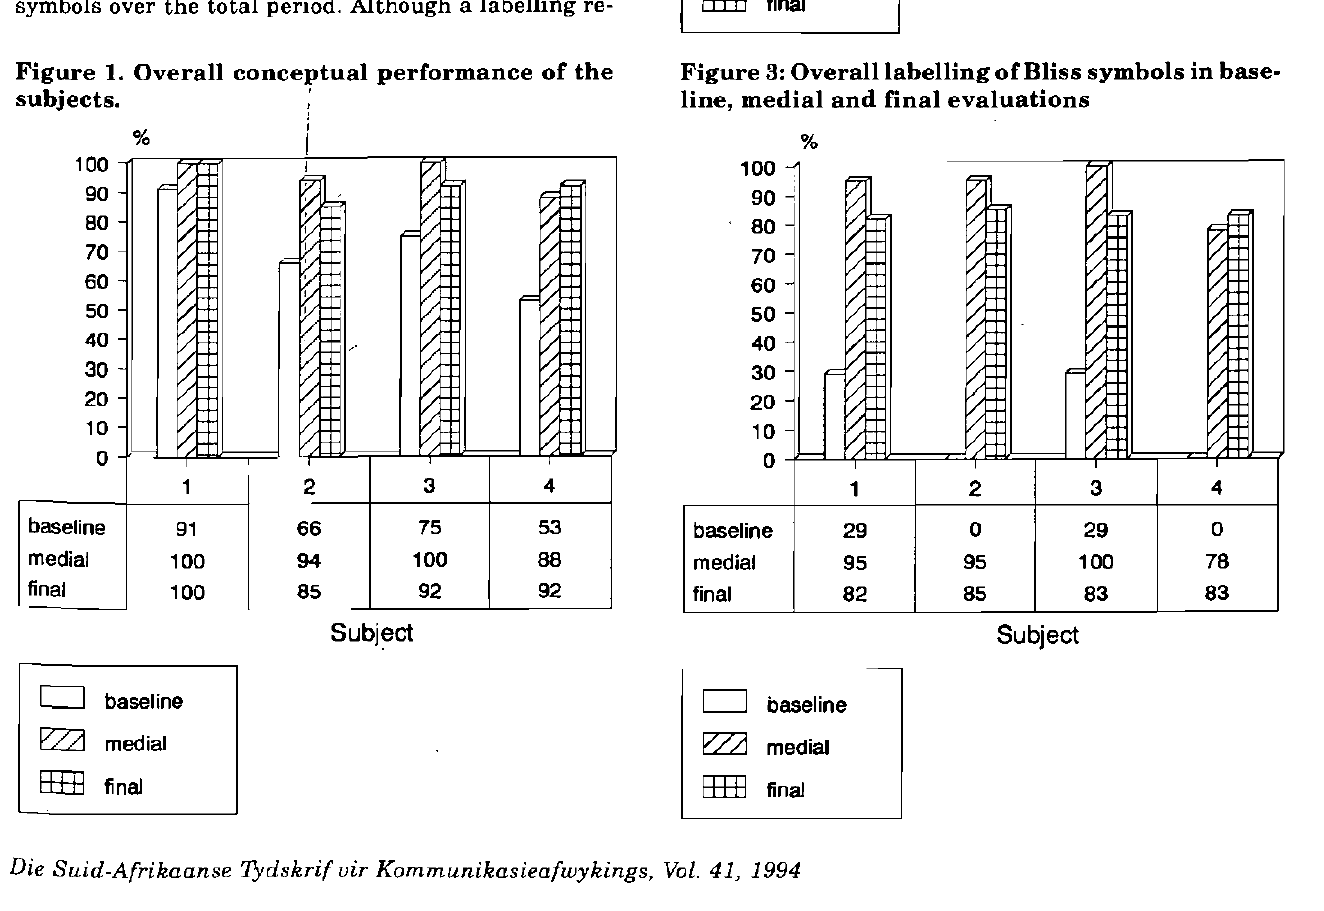
Figure 1. Overall conceptual performance of the subjects.